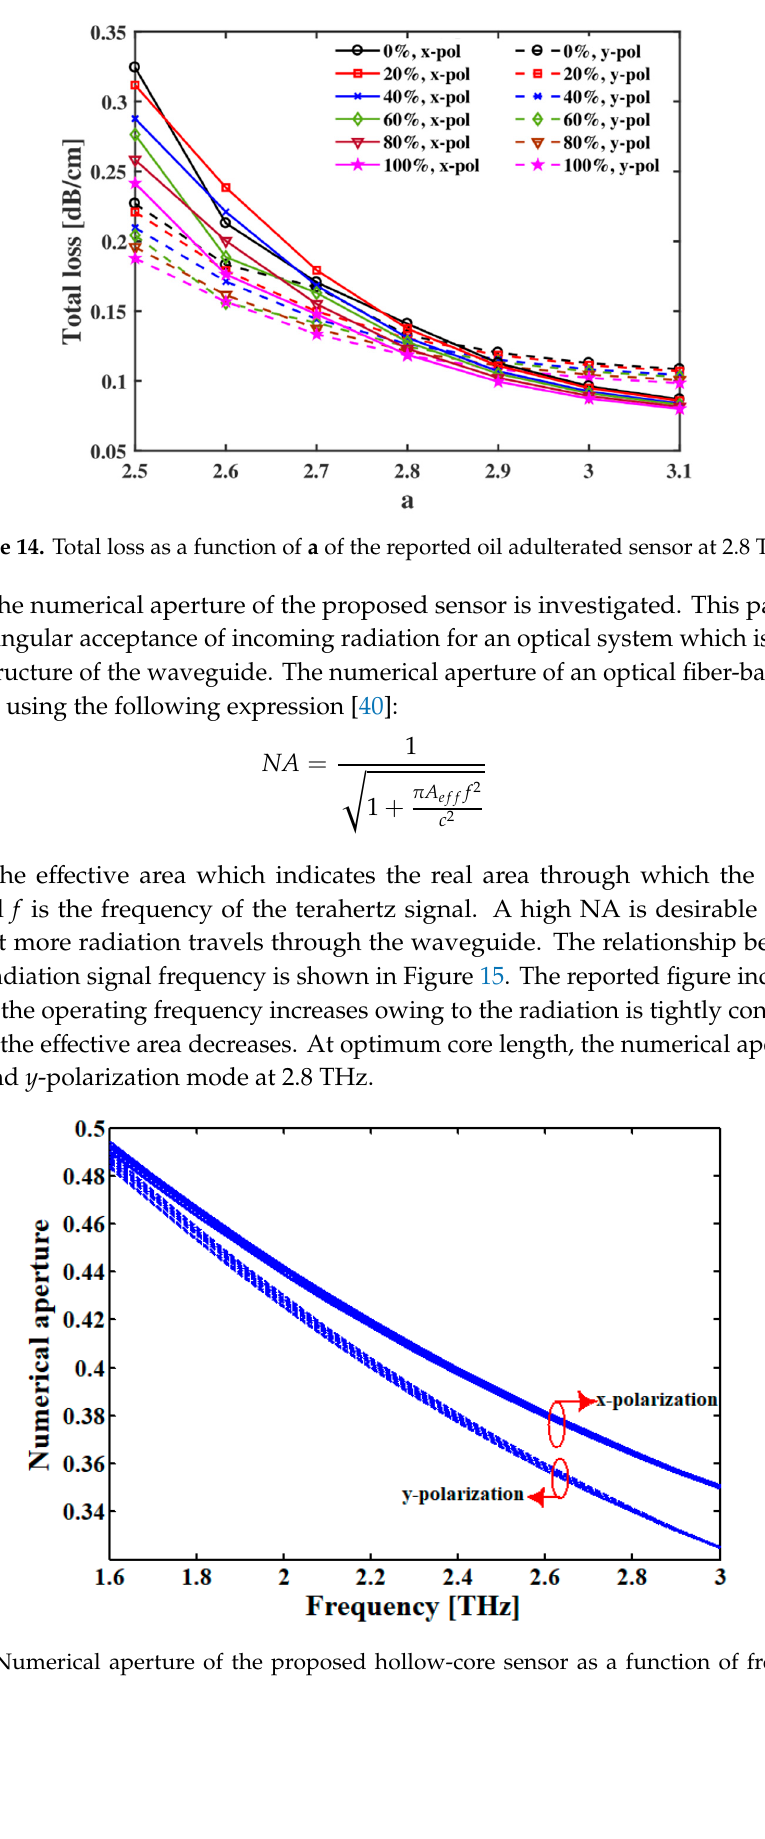
Figure 13. Variation of total loss of that fiber for different AFF at 2.8 THz and L = 280 µm.